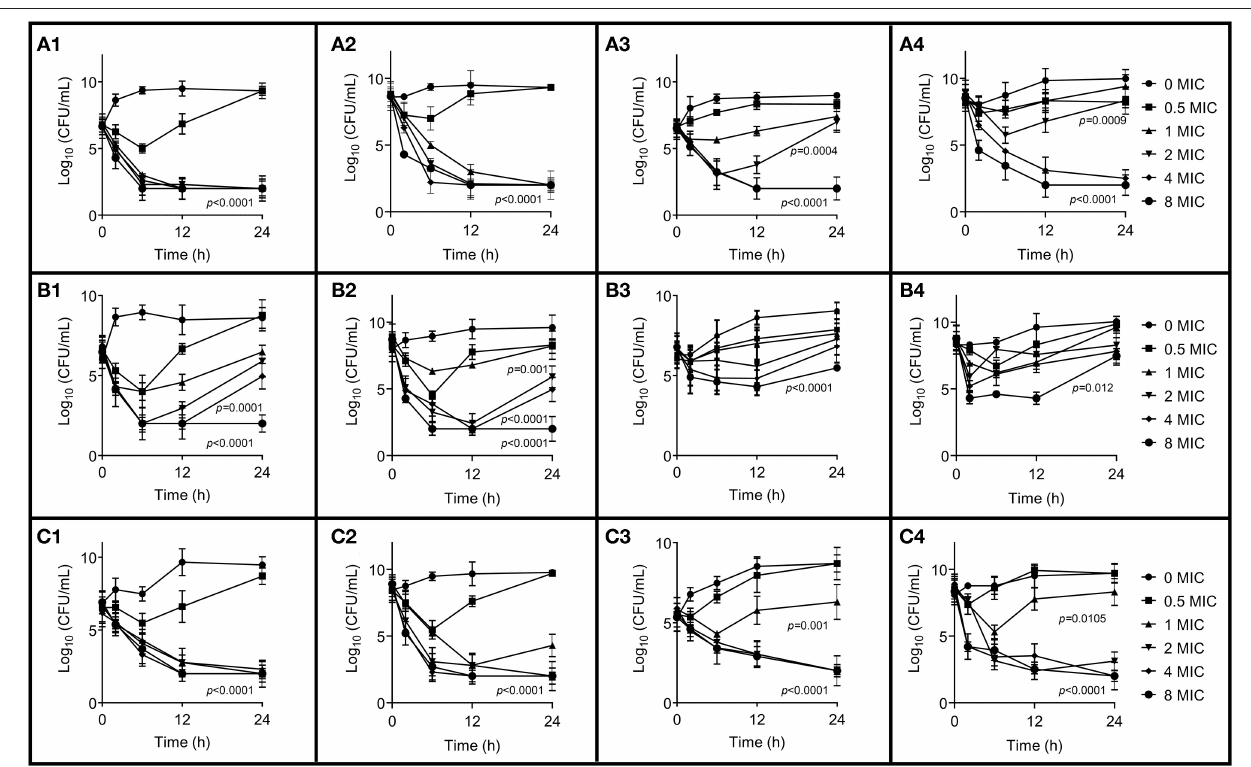
FIGURE 2 | In vitro time-killing curves of cefquinome in broth and milk against S. aureus ATCC 29213, B4048RH-31.4, and 2014RQG-33.15, respectively. (A1 – A4) Represents the S. aureus ATCC 29213, (B1–B4) represents the S. aureus B4048RH-31.4, and (C1–C4) represents the S. aureus 2014RQG-33.15. (A1,B1,C1) Show antibacterial activity against an initial bacterial load of 10 6 log 10 CFU/mL in broth, and (A2,B2,C2) show antibacterial activity against t initial bacterial load 10 8 log 10 CFU/mL in broth. (A3,B3,C3) Show antibacterial activity against an initial bacterial load of 10 6 log 10 CFU/mL in milk, and (A4,B4,C4) show antibacterial activity against an initial bacterial load of 10 8 log 10 CFU/mL in milk. Error bars represent the SD ( n = 3) and p -value were calculated by Student’s t